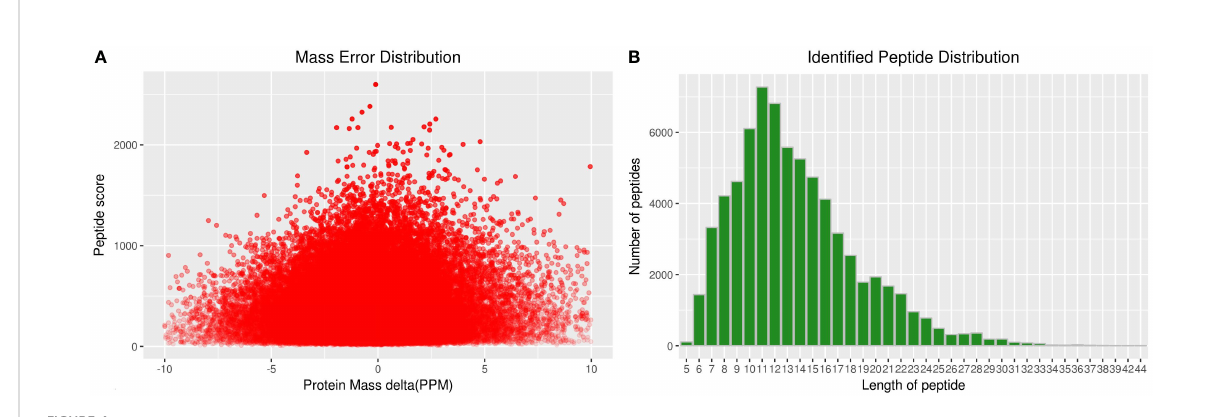
FIGURE 4 Total identi fi ed protein distribution of adult schistosomes.